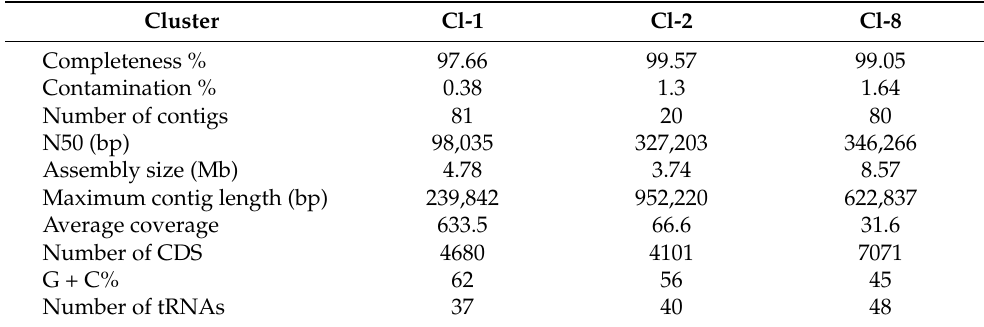
Table 2. Statistics for selected cluster genomes.